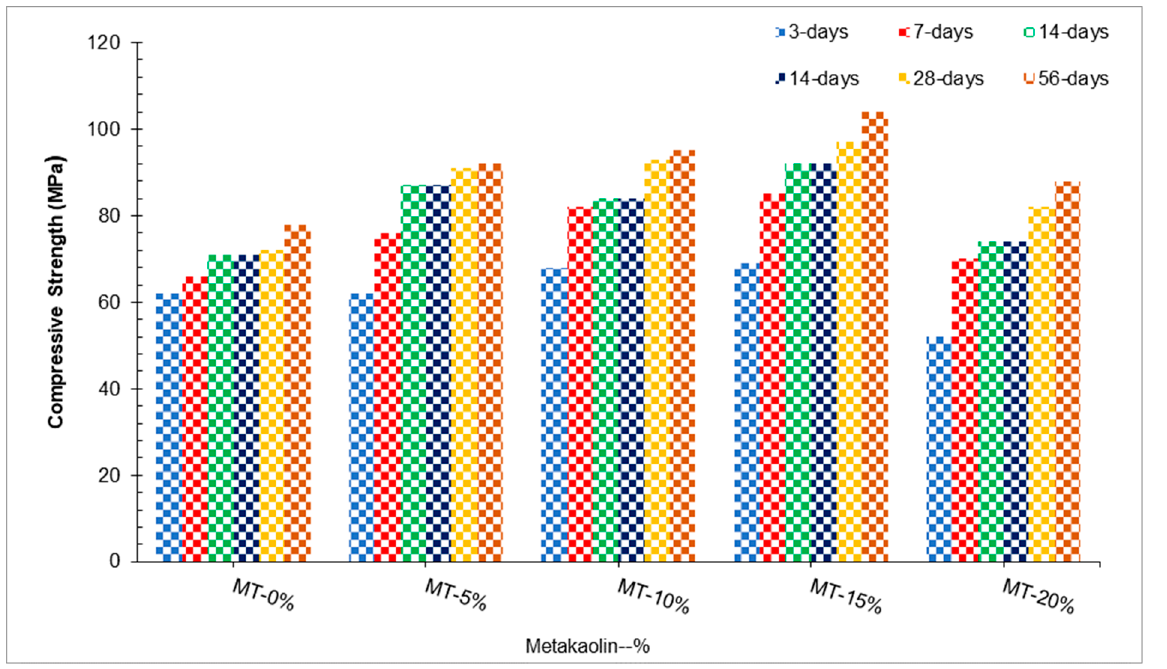
Figure 4. Compressive strength